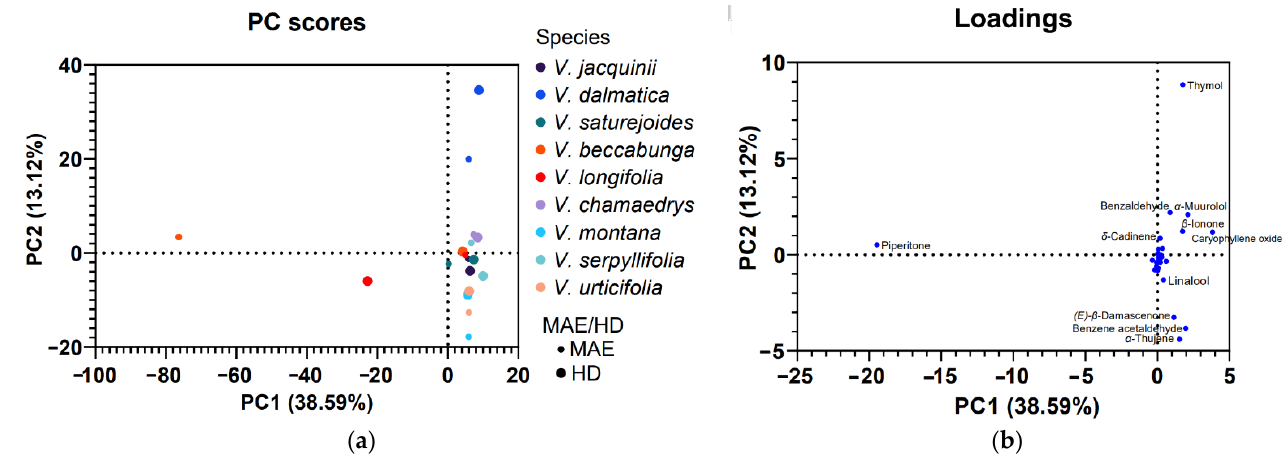
Figure 2. ( a ) PCA analyses of volatile compounds of 9 Veronica species–hydrodistillation (HD) and microwave assisted extraction (MAE); ( b ) PCA loading plots of volatiles from the first and second principal component .